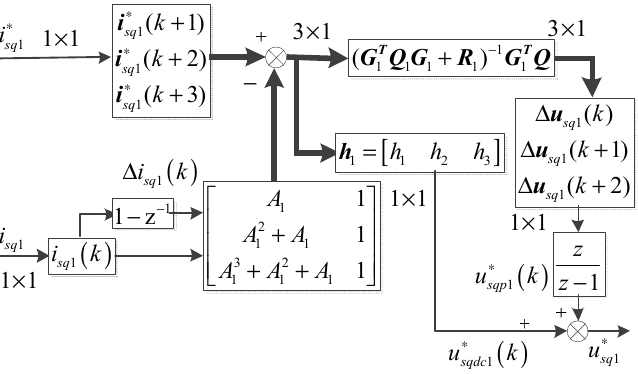
Table 1. Parameters of the nine-phase induction motor. Motor Parameters